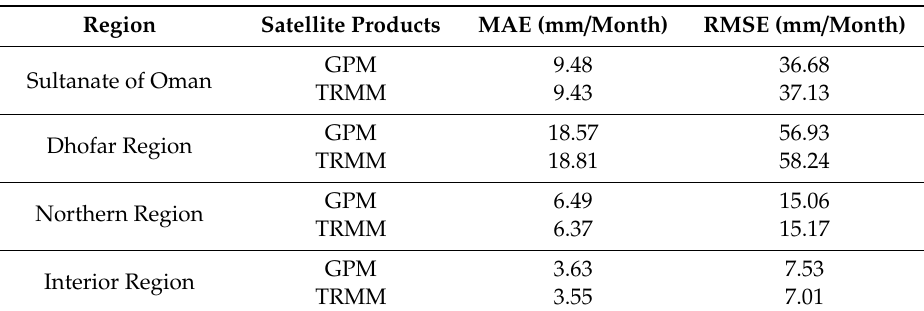
Figure 8. Spatial distribution and variability of annual precipitation from the rain gauge stations and satellite products in Oman, 2016 ( a ), 2017 ( b ), and 2018 ( c ). Table 5. Root Mean Square Error (RMSE) and Mean Absolute Error (MAE) between satellite products and OBSERVED estimates for Oman and its